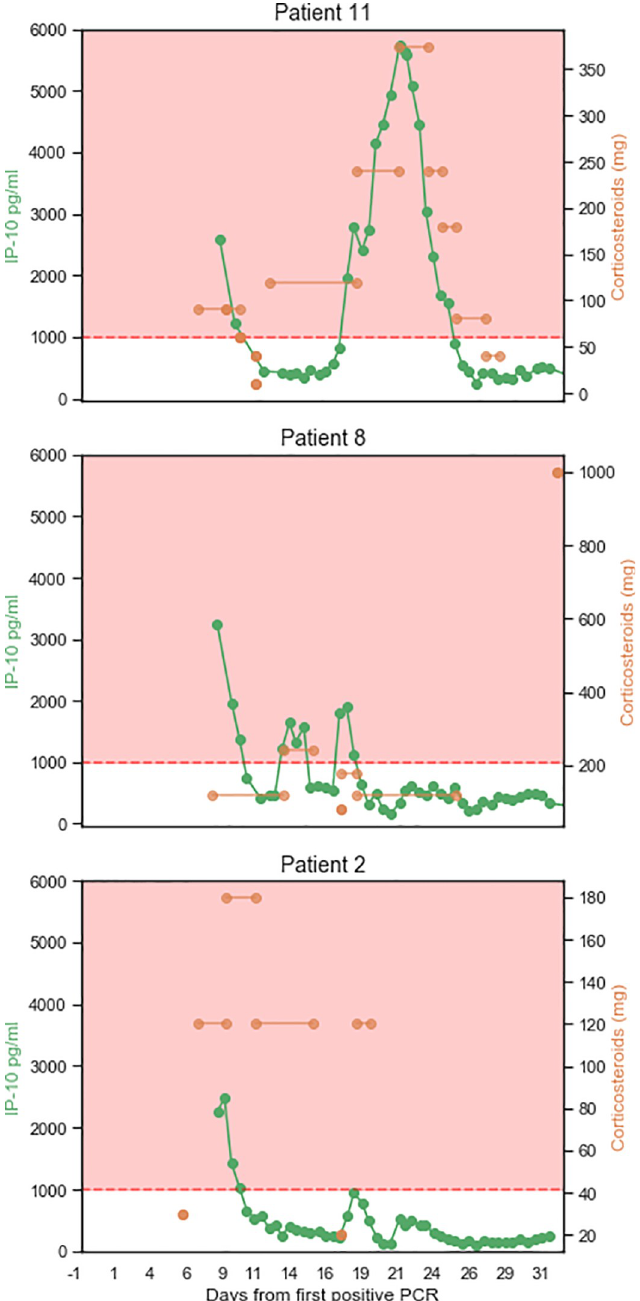
Fig 5. IP-10 levels reflect personalized corticosteroid dosing. Three patients exhibited a relapse wherein their IP-10 levels surged to exceed 1,000 pg/mL after an initial treatment with corticosteroids. The right Y axis shows the normalized levels of corticosteroids administered (the hydrocortisone dose was converted to a methylprednisolone dose). The left Y axis shows the levels of IP-10 measured at the indicated time points. The X axis shows the days from the first positive SARS-CoV-2 polymerase chain reaction test. Lines connecting the doses indicate that the dose was given in each of the intervening days. The pink area indicates IP-10 levels exceeding 1,000 pg/mL. Patient 2 survived; Patients 8 and 11